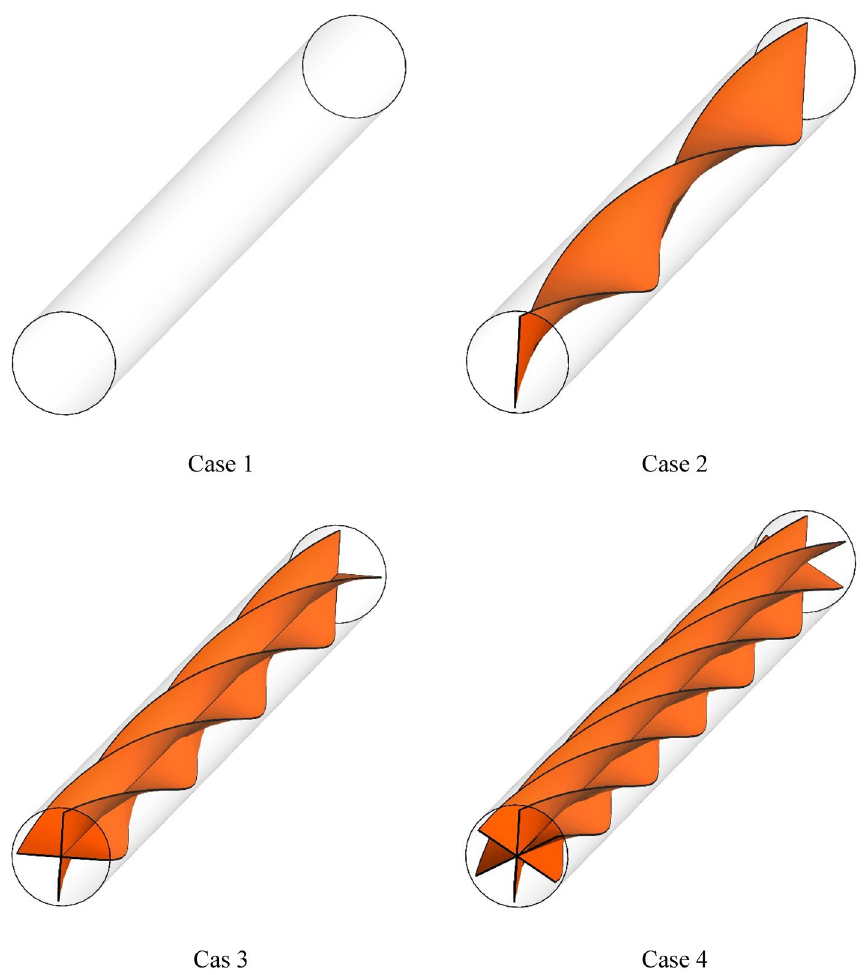
Figure 2. Introducing different geometric cases.